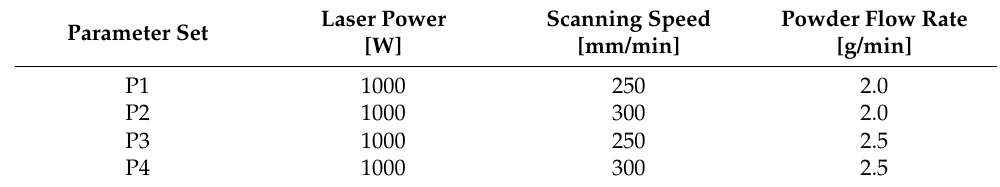
Table 3. Processing parameter sets. Parameter